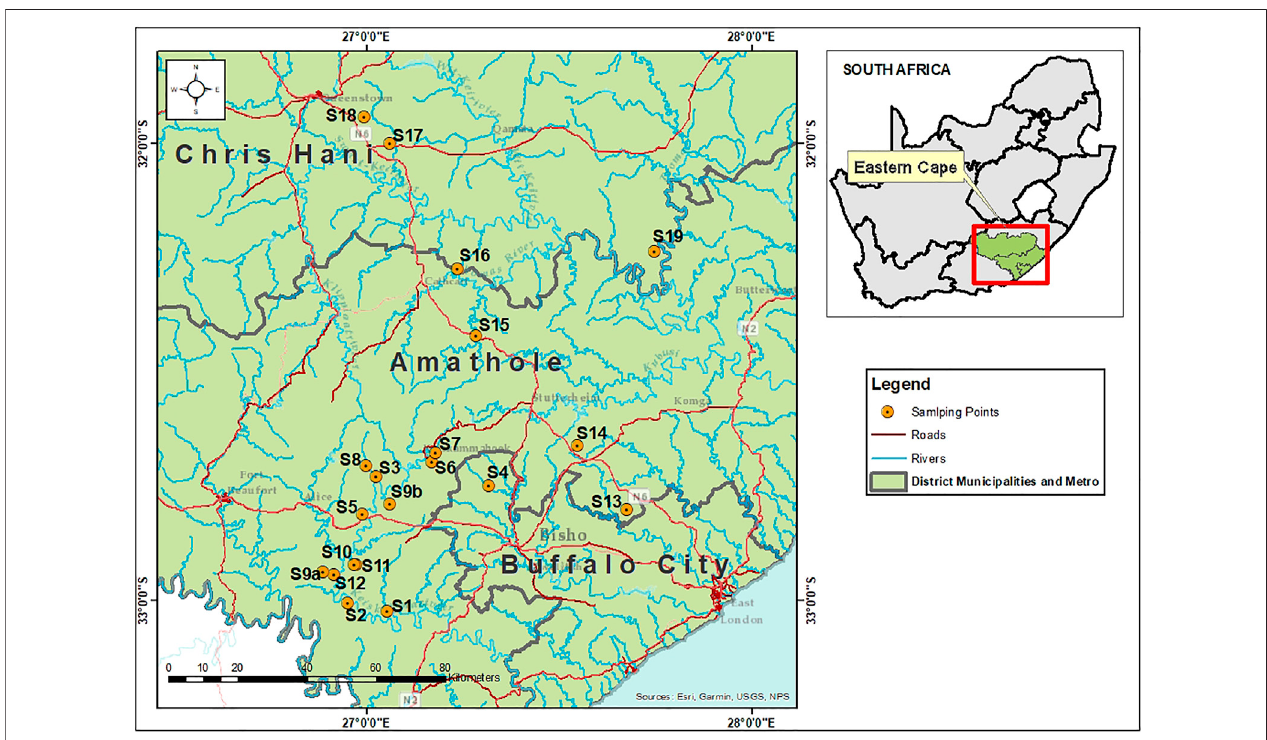
FIGURE 1 | Map showing the sampling sites in Amathole (S1-S15) and Chris Hani (S16-S19) District Municipalities, Eastern Cape Province, South Africa.